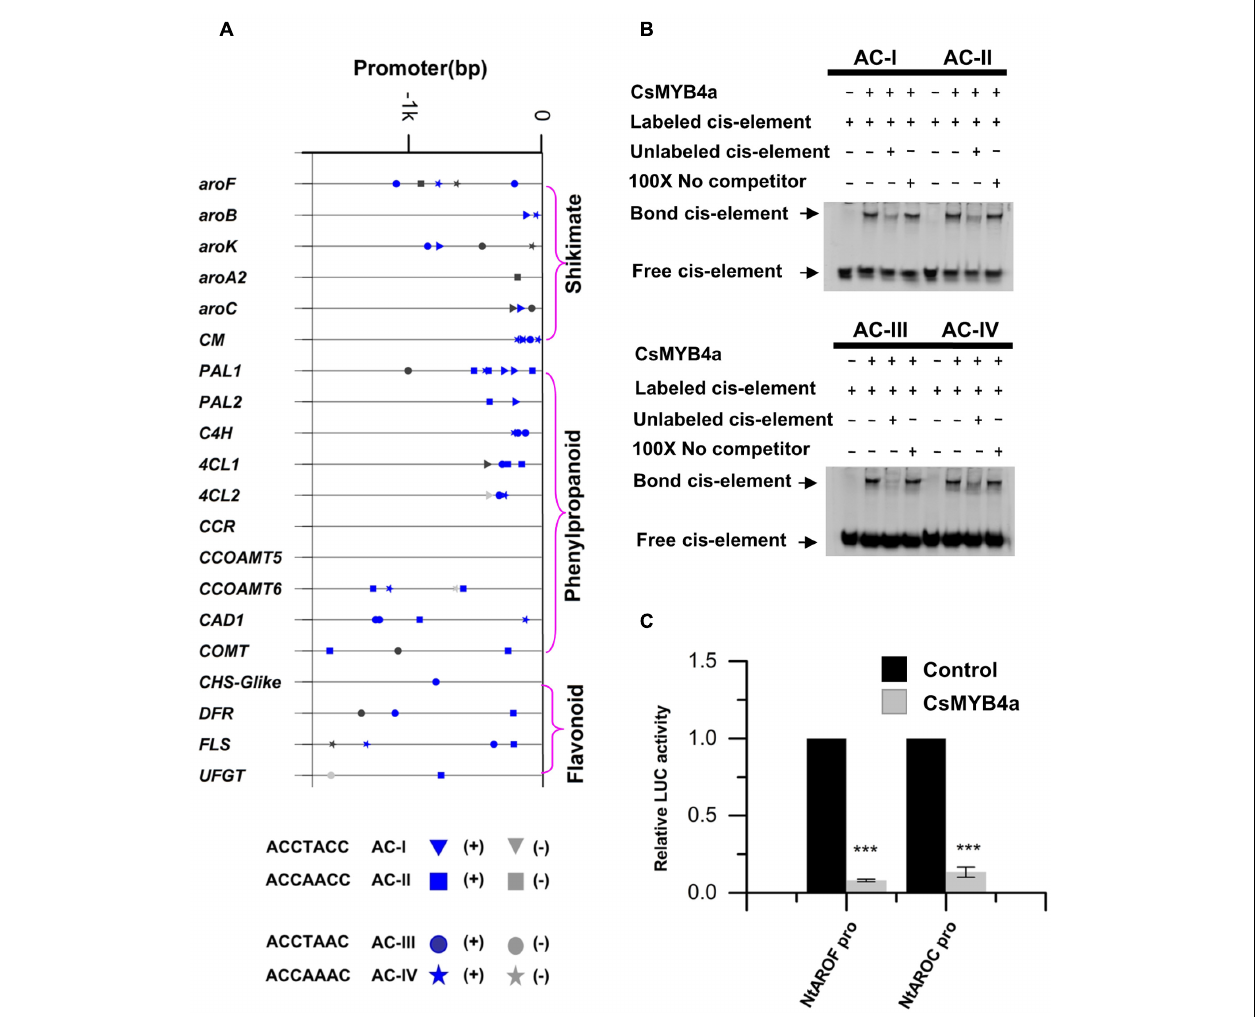
FIGURE 7 | Analysis of CsMYB4a binding AC-elements of promoters. (A) A diagram indicating the location of four AC-elements in the promoter region of selected differentially expressed tobacco genes. (B) EMSA assay of CsMYB4a protein possessing four AC-elements. Salmon sperm DNA was used as a